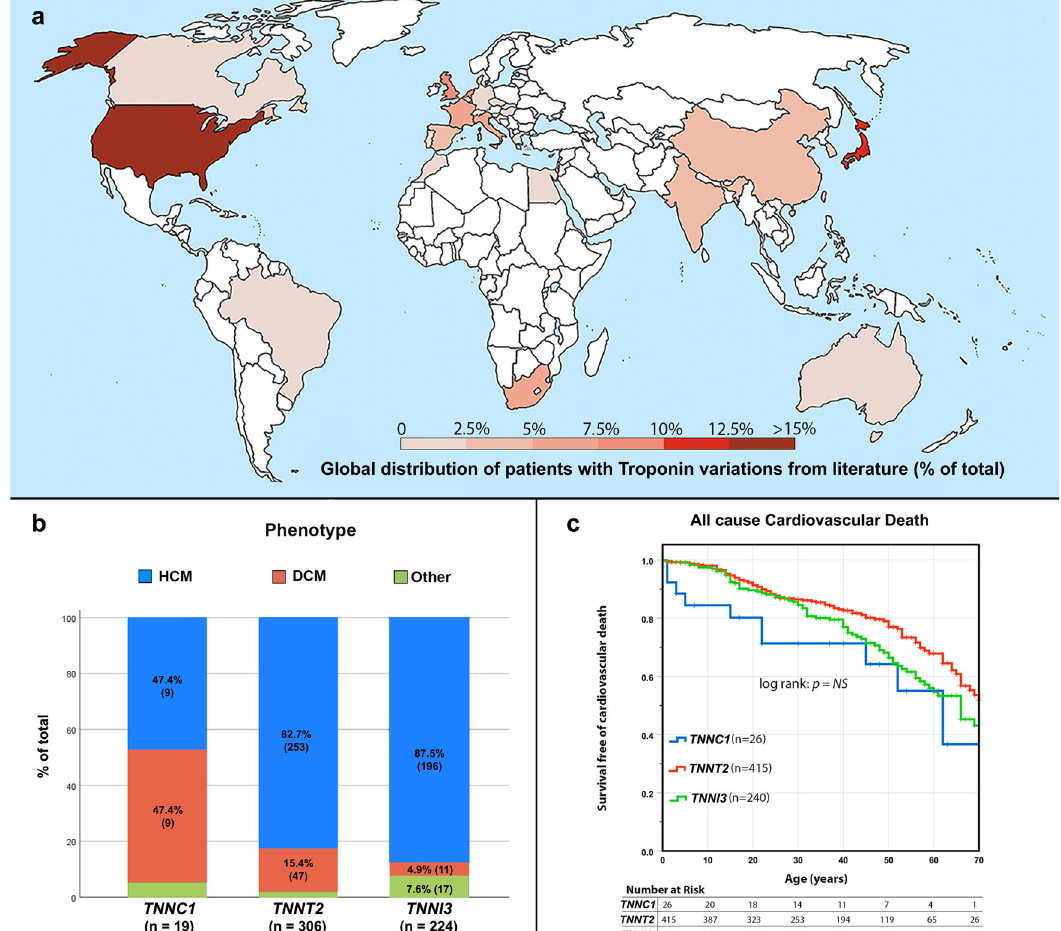
Fig. 5 Variations in the cardiac troponins described in the literature. a Global distribution of cardiomyopathy patients across countries (% from total) carrying pathogenic or likely pathogenic substitutions in the troponin complex. b Associated phenotype according to the presence of substitutions in TNNC1 , TNNT2 and TNNI3 . Differences were signi fi cant between the three groups ( p < 0.001). c Survival curves showing the freedom from cardiovascular death in variations in TNNC1 , TNNT2 and TNNI3 genes. The differences between genes did not reach statistical signi fi cance. (The map was modi fi ed by us from this fi gure:https://commons.wikimedia.org/wiki/File:World_map_nations.svg. The fi gure has a Creative Commons licence so the fi gure is free to use and edit: https://en.wikipedia.org/wiki/GNU_Free_Documentation_License )